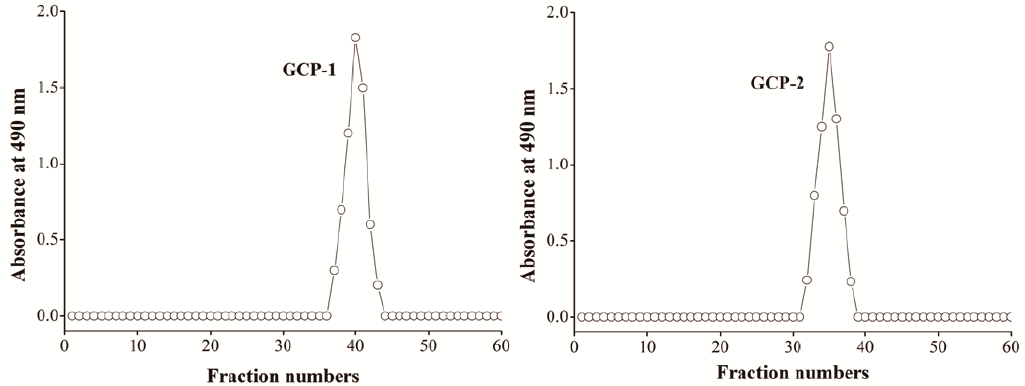
Figure 1. Elution profiles of GCP-1 and GCP-2 in the Sepharose CL-6B column chromatography.